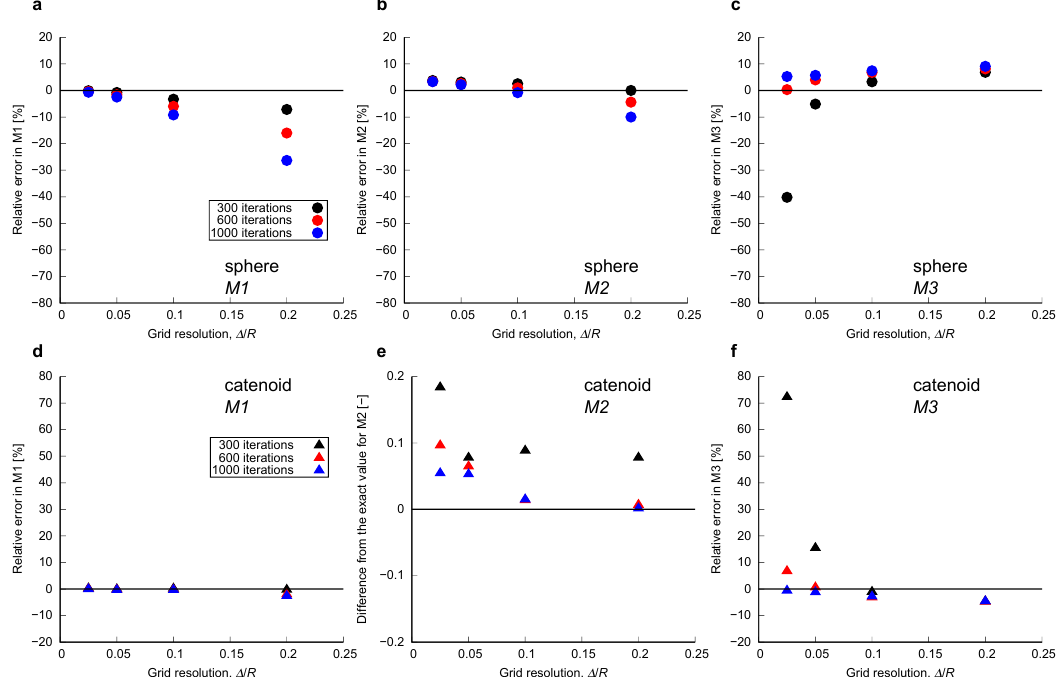
Figure 6. Errors in the estimation of M 1 , M 2 and M 3 as a function of dimensionless resolution, ∆ / R . M 1 is the surface area, M 2 is the surface-averaged mean curvature and M 3 is the surface-averaged Gaussian curvature. Errors in ( a ) M 1 , ( b ) M 2 and ( c ) M 3 for the sphere. Errors in ( d ) M 1 , ( e ) M 2 and ( f ) M 3 for the catenoid. Different iterations of the smoothing procedure were